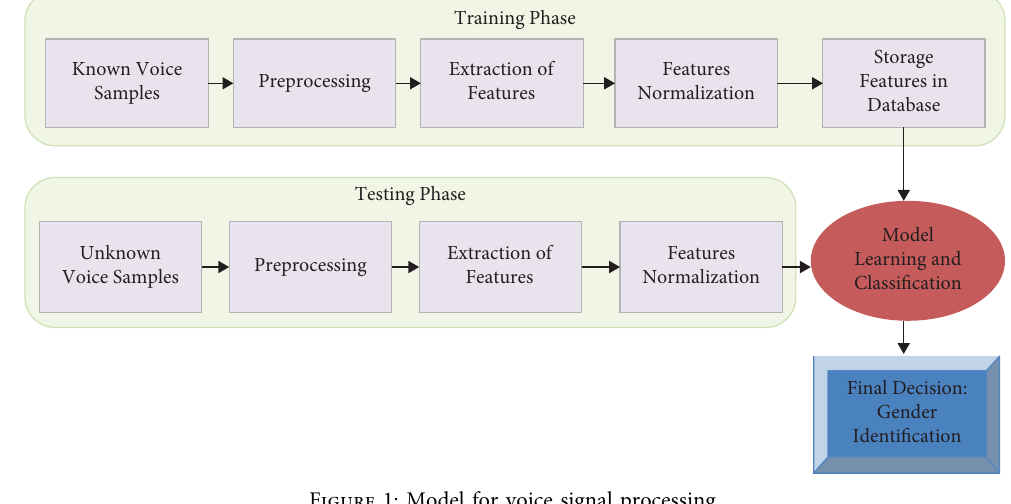
Figure 1: Model for voice signal processing. Table 1: Datasets for error rate and precision values.